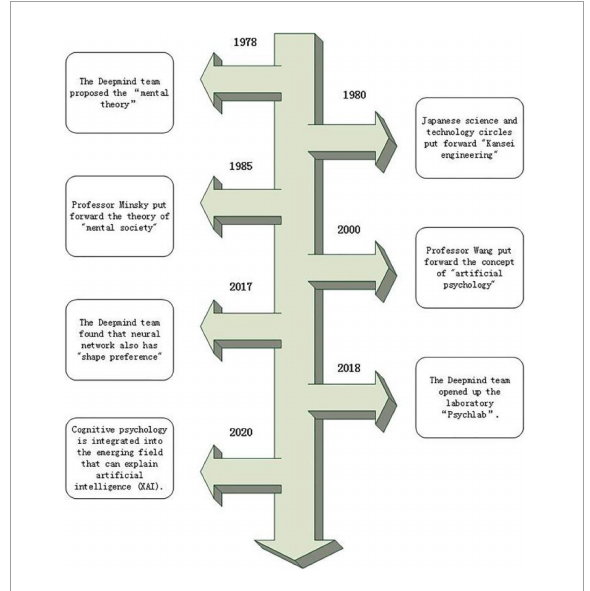
FIGURE1 The evolution of artificial intelligence in cognitive